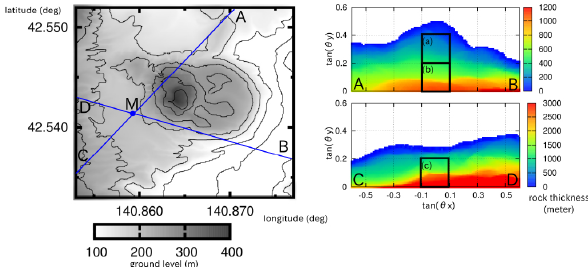
Fig. 4. Topological map of the Showa-Shinzan lava dome, Usu, Japan. “M” shows the position of our emulsion detectors. The obser- vation ranges of the muon detector are given by 6 AMB (forward) and 6 CMD (backward). The thicknesses of the material along the radial directions are represented in the two color-contour maps to the right. The squares (a) , (b) and (c) indicate three angular domains for which the particle fluxes are